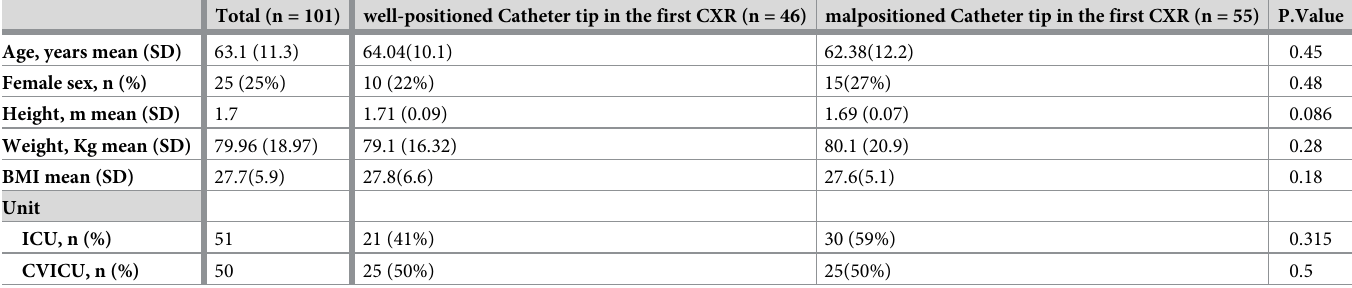
Table 1. Patient characteristics, compared between initially well-positioned and malpositioned CVCs according to CXR after insertion. Total (n = 101) well-positioned Catheter tip in the first CXR (n = 46) malpositioned Catheter tip in the first CXR (n = 55) P.Value